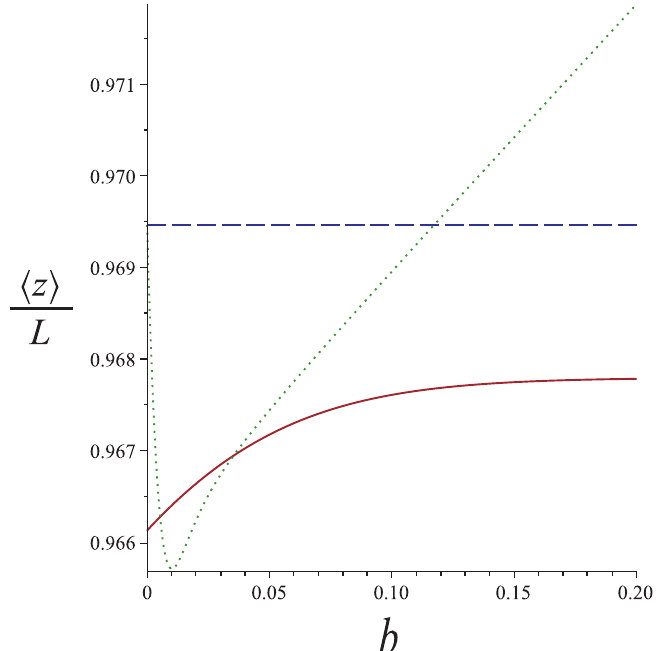
Figure 8. The mean extension of a semiflexible nunchuck in 2 d as a function of the hinge position b for l p = L and f = 150 k B T / L . The solid line corresponds to the weakly bending approximation of the hinged WLC (Equation (38)). The dotted line corresponds to a nunchuck whose small arm is a rigid rod and the long arm a weakly bending WLC (Equation (43)). The dashed line gives the extension of the corresponding intact WLC (without any